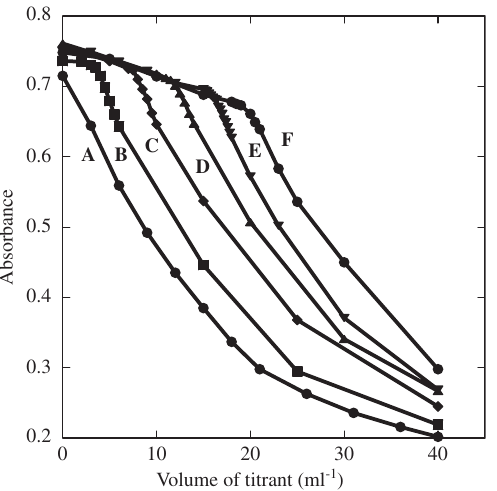
Figure 5 Effect of the concentration of CV on the sharpness of the end point detection for the titration of a 1.0 × 10 -5 eq mol l -1 PHMB-HCl solution (50.00 ml) with a 1.0 × 10 -4 eq mol l -1 PVSK standard solution. Concentration of CV: (1) 1.2 × 10 -5 , (2) 1.0 × 10 -5 , (3) 8.0 × 10 -6 , (4) 6.0 × 10 -6 , (5) 4.0 × 10 -6 mol l -1 .